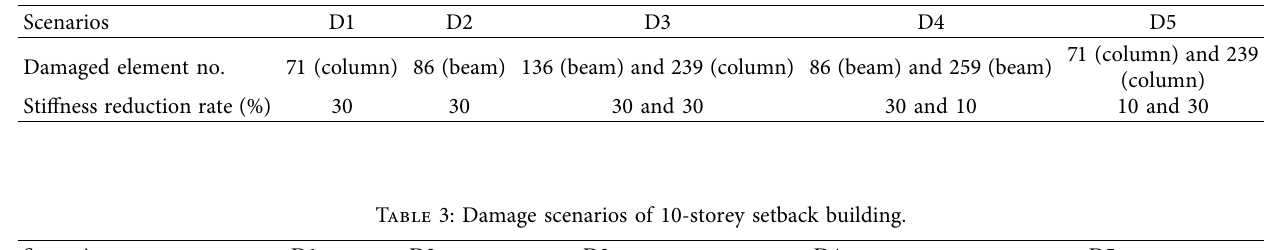
Table 2: Damage scenarios of 10-storey L-shape building.